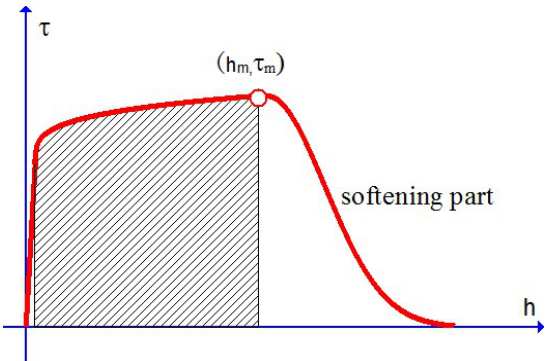
Figure 6. Uniaxial tensile curve explaining the three parameters in Equation (9): the tensile strength τ m and the area of the shading part provide approximate values of the maximum stress limit q 0 and the critical plastic work κ c , respectively, and the slope of the softening part specifies the softening index β